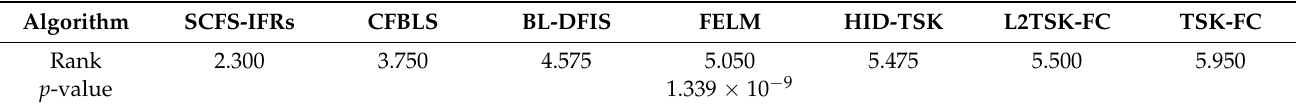
Table 10. Result of Friedman tests (significance level of